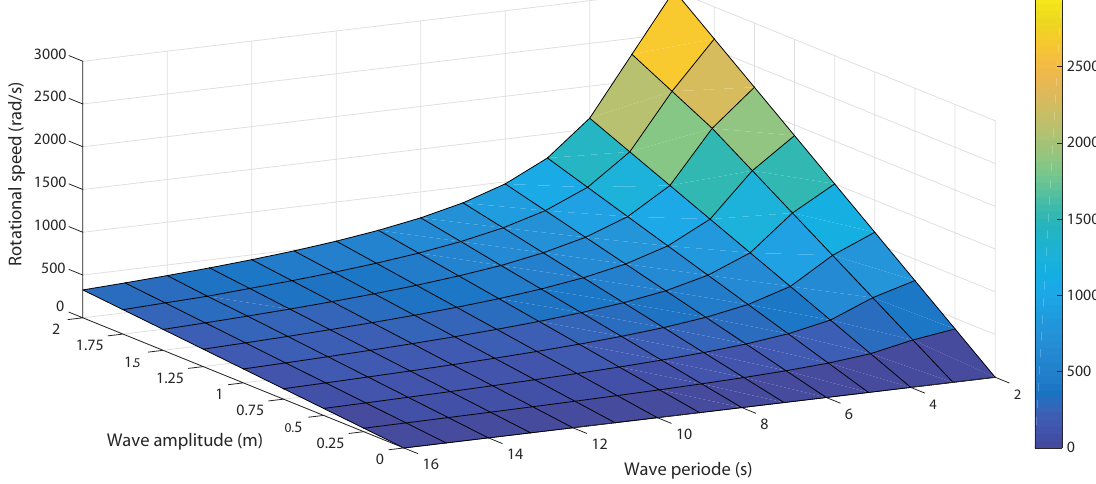
Figure 16. Minimum rotational speed for different wave amplitude and